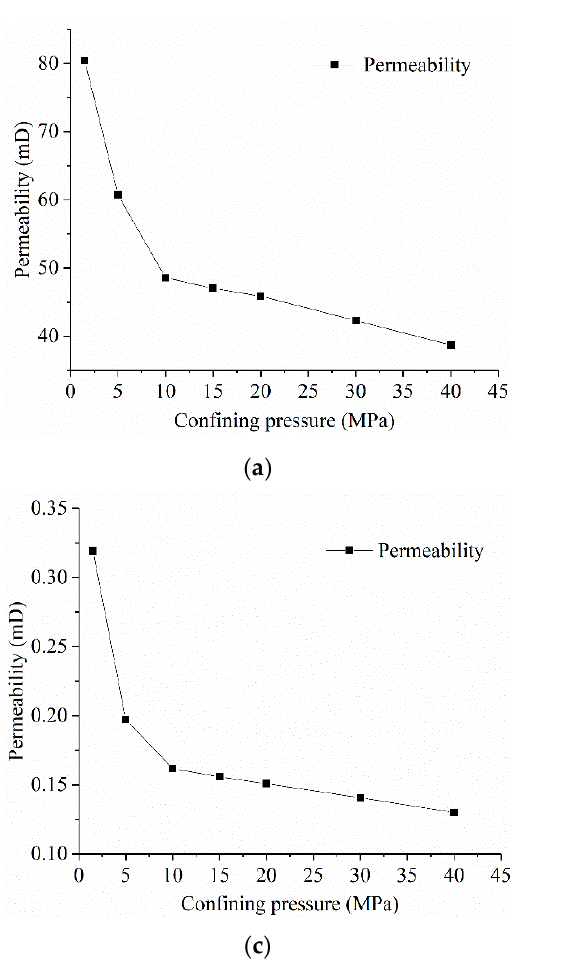
Figure 9. Permeability variation of the four subcategories of sandstone with different confining pressures: ( a ) subcategory I 1 sandstone; ( b ) subcategory II 2 sandstone; ( c ) subcategory II 1 sand- stone; ( d ) subcategory II 2